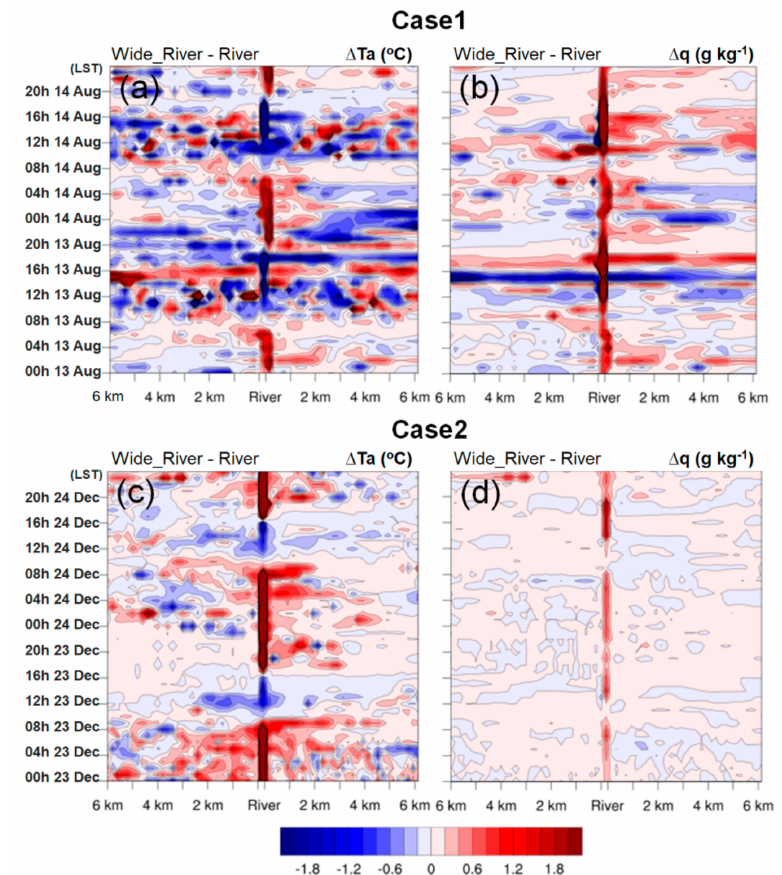
Figure 7. The Hovmöller diagram of the ∆ Ta ( a , c ) and ∆ q ( b , d ) with distance up to 6 km from the river (abscissa–axis) and time (ordinate–axis) for Case1 ( c ) and Case2 ( d ). The location of the cross section is indicated by the line between points A and B in Figure